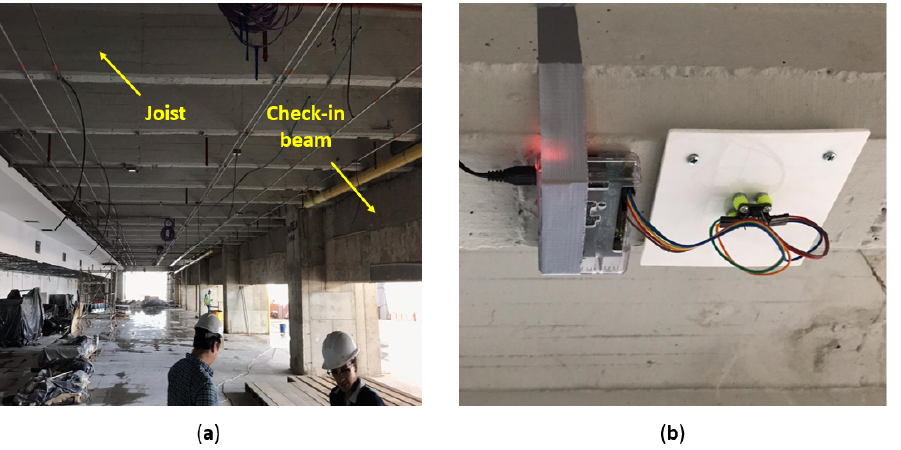
Figure 6. Beam demolition monitoring: ( a ) Joists of the slab and check-in beam. ( b ) Measuring node.